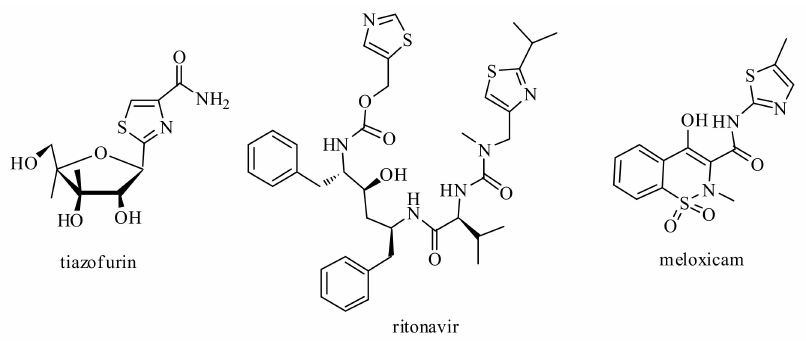
Figure 3. Approved drugs with thiazole